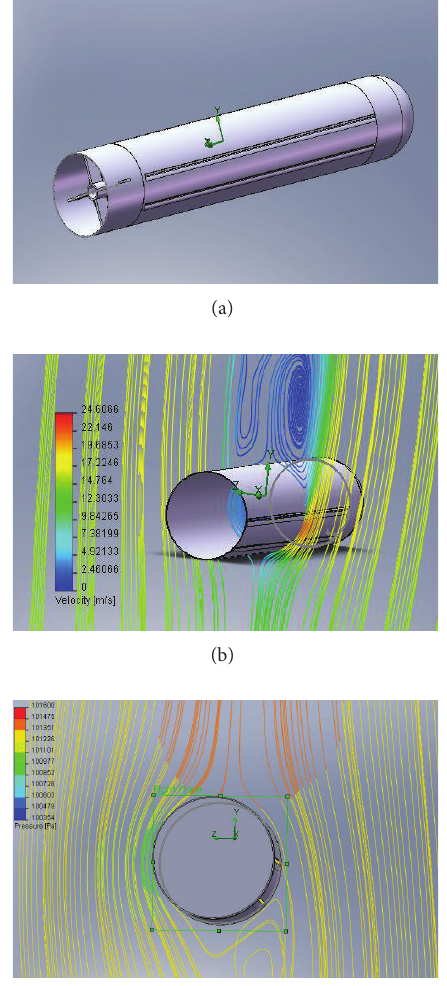
Figure 6: Simulation of the flow around the tail of IAR 316 B helicopter.